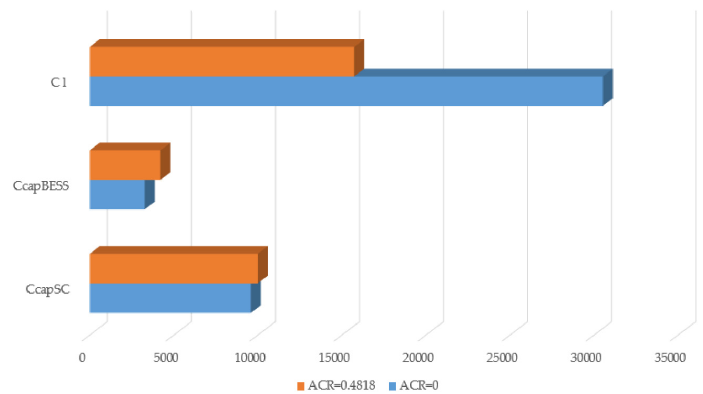
Figure 11. Compensated energy shortage ( ACR = 0).